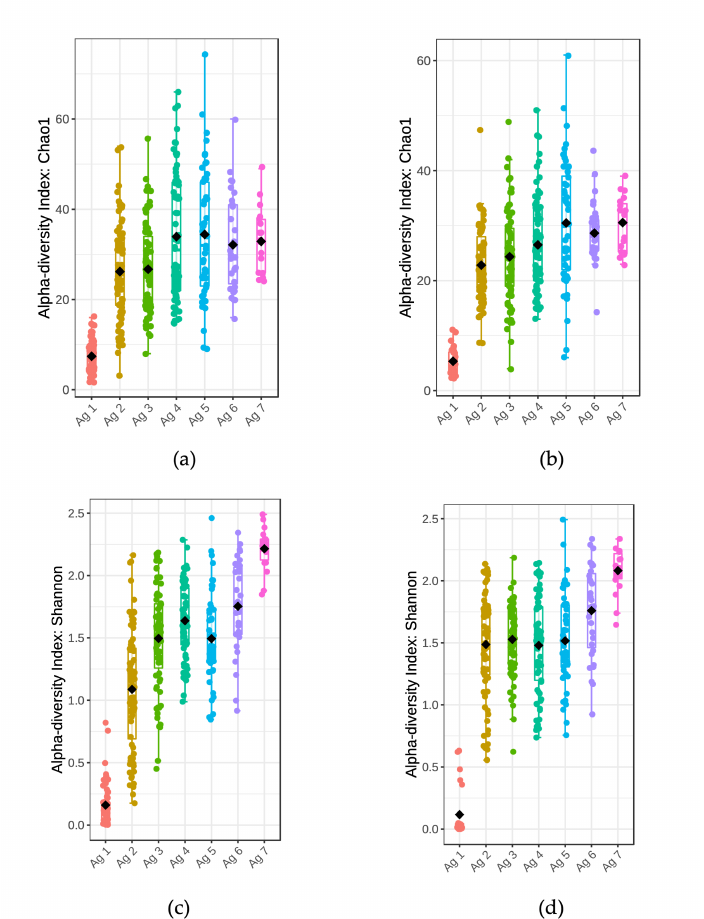
Figure 7. Measures of alpha diversity using 16S rRNA gene amplicon profiles at genus-level classifi- cation of OTUs generated from total and viable cell DNA ( a , c ): total DNA, ( b , d ): PMA-treated DNA) from 13 trials during 32 m of ripening. ( a , b ) Chao1 and ( c , d ) Shannon diversity index of each age group (indicated with a separate color). Ag 1: 0–1 m, Ag 2: 3–6 m, Ag 3: 7–10 m, Ag 4: 12–15 m, Ag 5: 18–20 m, Ag 6: 24 m, Ag 7: 30–32 m.